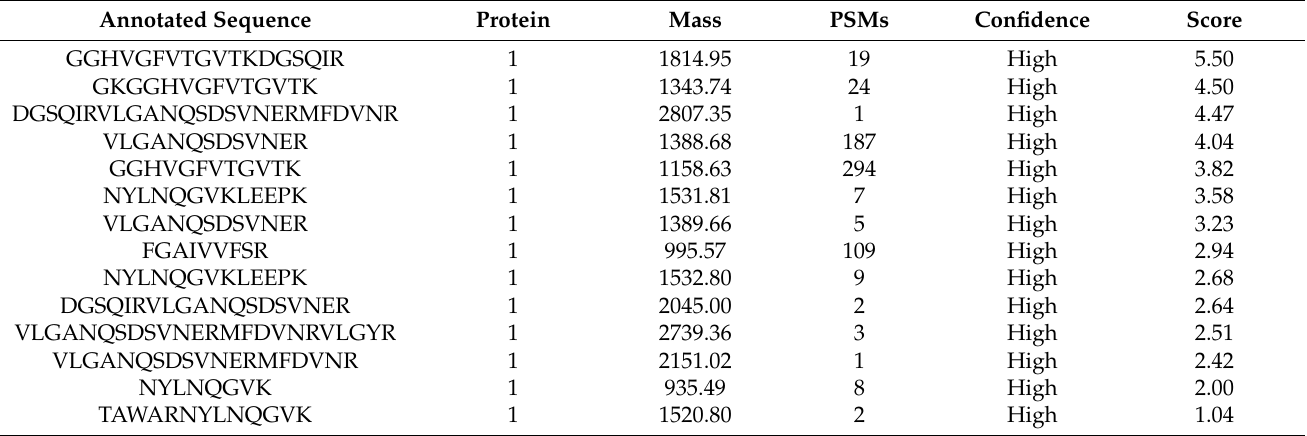
Table 1. List of peptides originating from Plychap001 that were identified by LC-MS/MS. Annotated Sequence Protein Mass PSMs